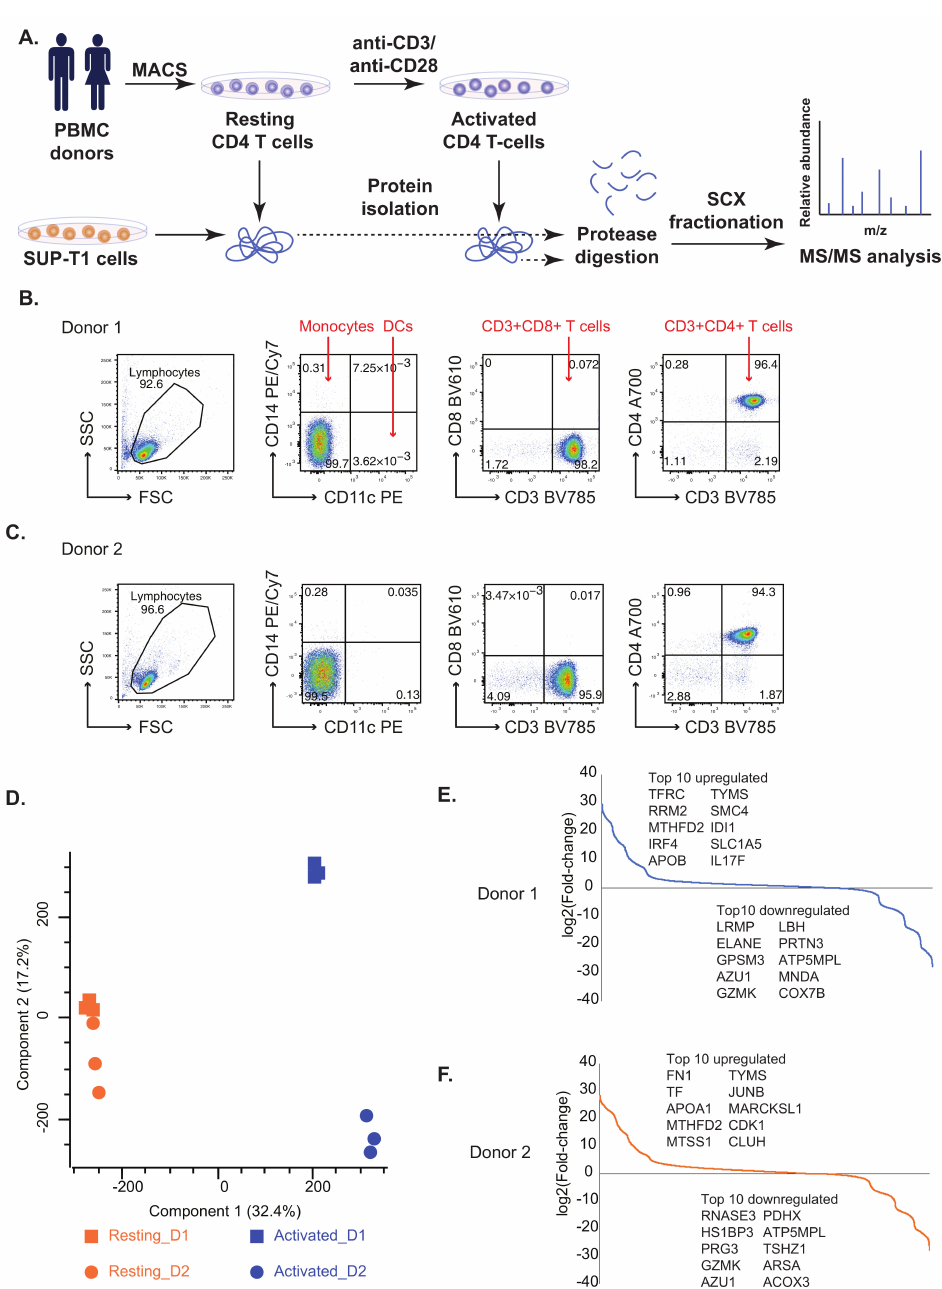
Figure 1. ( A ) A workflow for the comparative proteomics analysis of resting and activated primary human CD4+ T cells as well as SUP-T1 lymphoma T cells. Primary human CD4+ T cells were purified using magnetic beads (MACS cell separation) from PMBCs of healthy donors. Resting (unstimulated) CD4+ T cell samples were harvested (washed and shock-frozen) for protein extraction immediately after isolation. A fraction (1 × 10 7 ) CD4+ T cells were activated for 72 h by anti-CD3/anti-CD28 stimulation before cells were harvested/shock-frozen for protein isolation. SUP-T1 cells were harvested from a cell line tissue culture. Resting CD4+ T cells, activated CD4+ T cells and SUP-T1 cell samples were subjected to protein extraction. Proteins were subjected to tryptic digestion. Peptide samples obtained were subjected to strong cation exchange chromatography followed by MS/MS analysis. ( B , C ) Flow cytometric purity analysis of CD4+ T cell preparations for Donor 1 ( B ) and Donor 2 ( C ). Purified CD4+ T cells were stained with fluorescent antibodies for CD11c, CD14, CD3, CD8 and CD4. Both preparations contained >94% CD3+CD4+ T cells and (in total) less than 0.5% contaminating CD11c+, CD14+ or CD8+ cells. ( D ) Principal Component Analysis (PCA) plot depicting common proteomic patterns in resting/resting CD4+ T cells and activated CD4+ T cells. ( E , F ) S-curve graphs showing the distribution of fold-changes in Donors 1 and 2 and the top differentially expressed